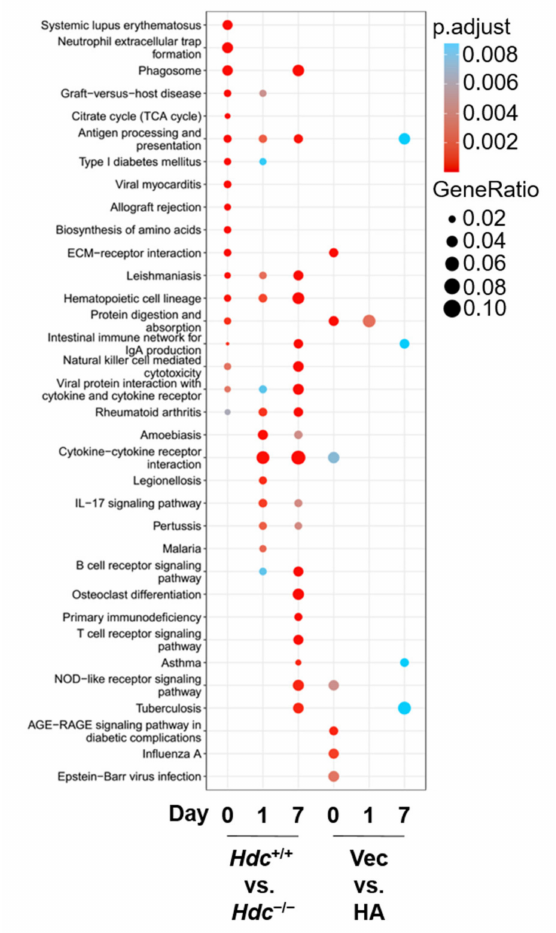
Figure 4. KEGG analysis of differentially expressed genes. The size of the point represents the ratio of gene numbers enriched in a given pathway in the background, whereas the background of the gene at each time point is the input of all the gene sets at that time point. The color of the dots represents the adjusted p value, whereas the blue to red gradient shows the statistical significance from low to high